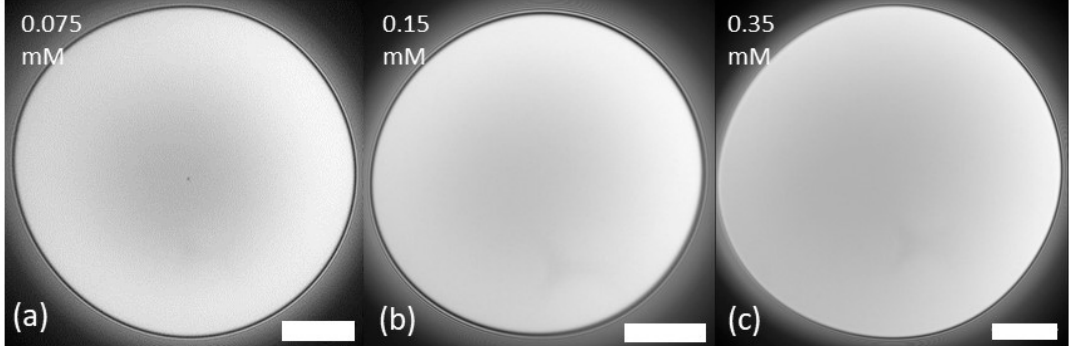
Figure 2. Morphology of LAE surfactant films after the pressure step of 100 Pa at the end of the drainage. ( a ) LAE 0.075 mM (the film was unstable, the image was taken before the rupture after c.a. 40 s drainage); ( b ) LAE 0.15 mM; ( c ) LAE 0.35 mM. Scale bar 100 μ m.